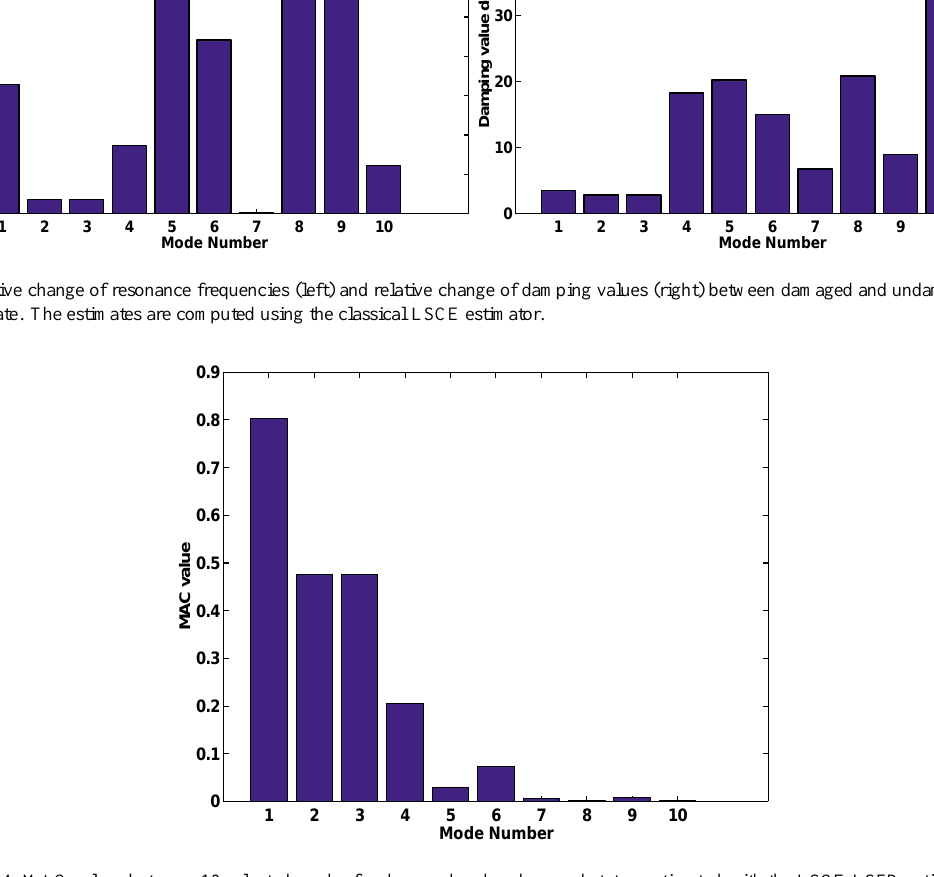
Fig. 4. MAC values between 10 selected modes for damaged and undamaged states, estimated with the LSCE-LSFD estimator. for k = 1 , . . . , N f